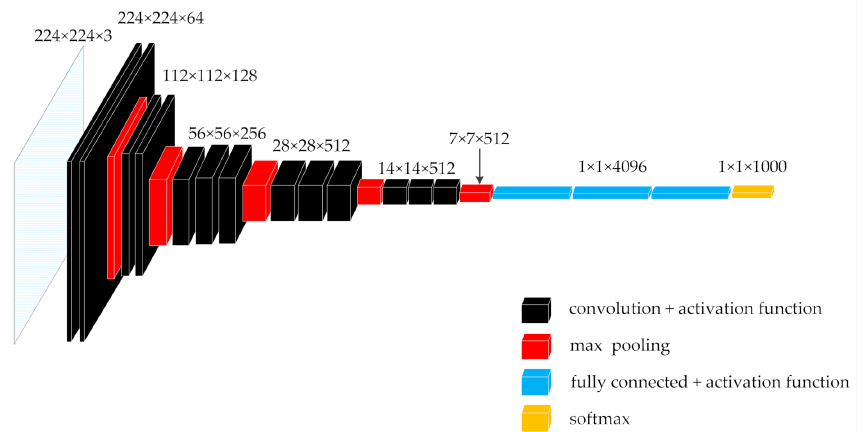
Figure 1. VGG16 network structure